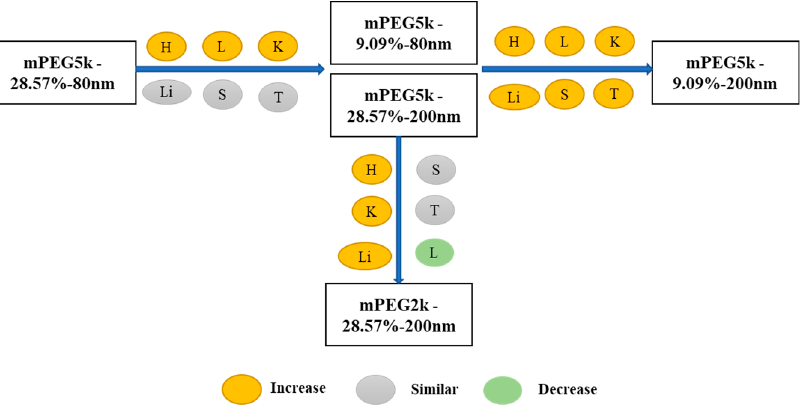
Figure 17. Multiple comparisons of K max (/h) for the five NP formulations. The yellow circle indicates increase, grey means similar and green represents decrease in the K max (/h) in various tissues.